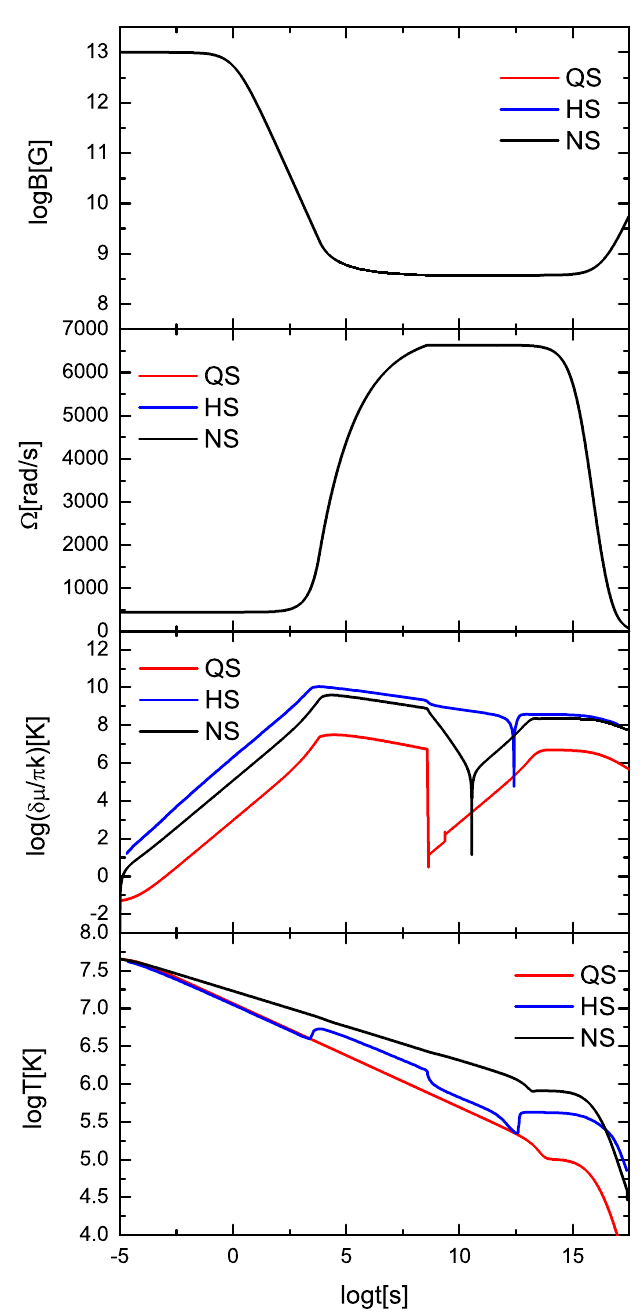
Figure 4. Surface magnetic field, spin angular frequency, chemical deviation, and surface temperature as a function of time with parameters of model 4. Pure neutron star, pure quark star, and hybrid star are represented by black line, red line and blue line, respectively. The units of the temperature, chemical deviation, magnetic field, spin angular frequency, and time are K, K, G, rad/s, and s,